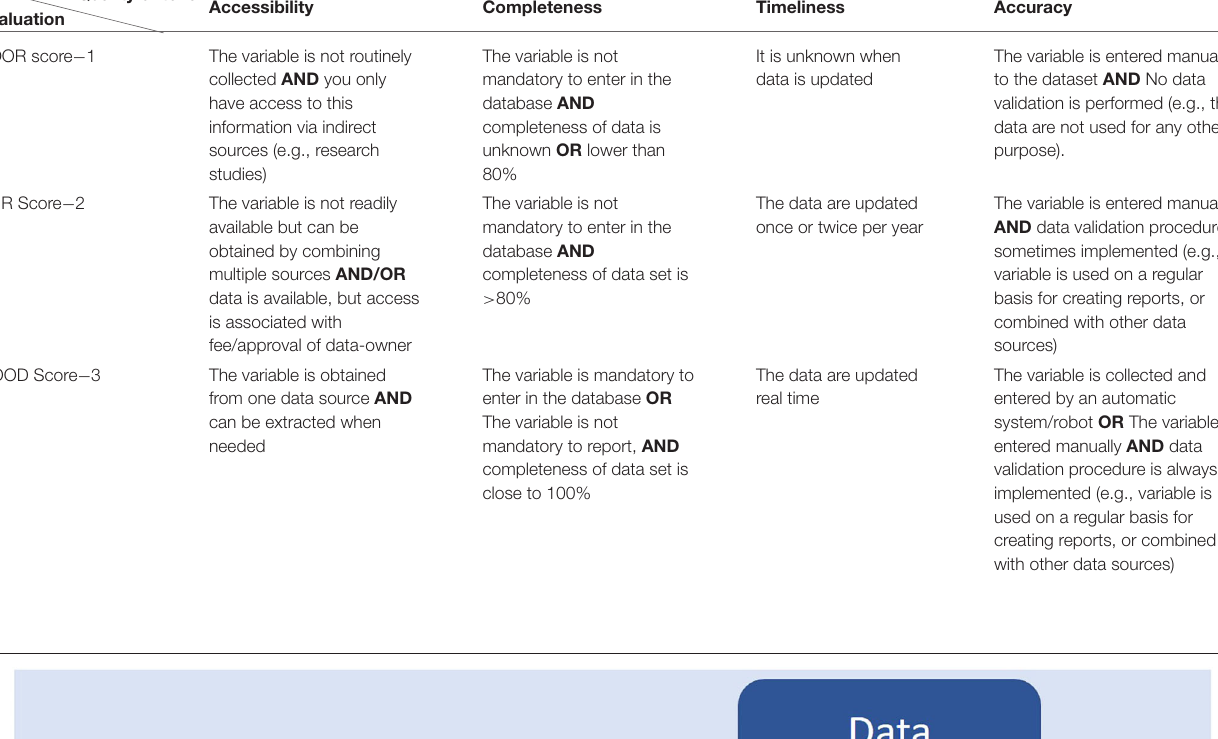
TABLE 6 | Data quality evaluation tool.